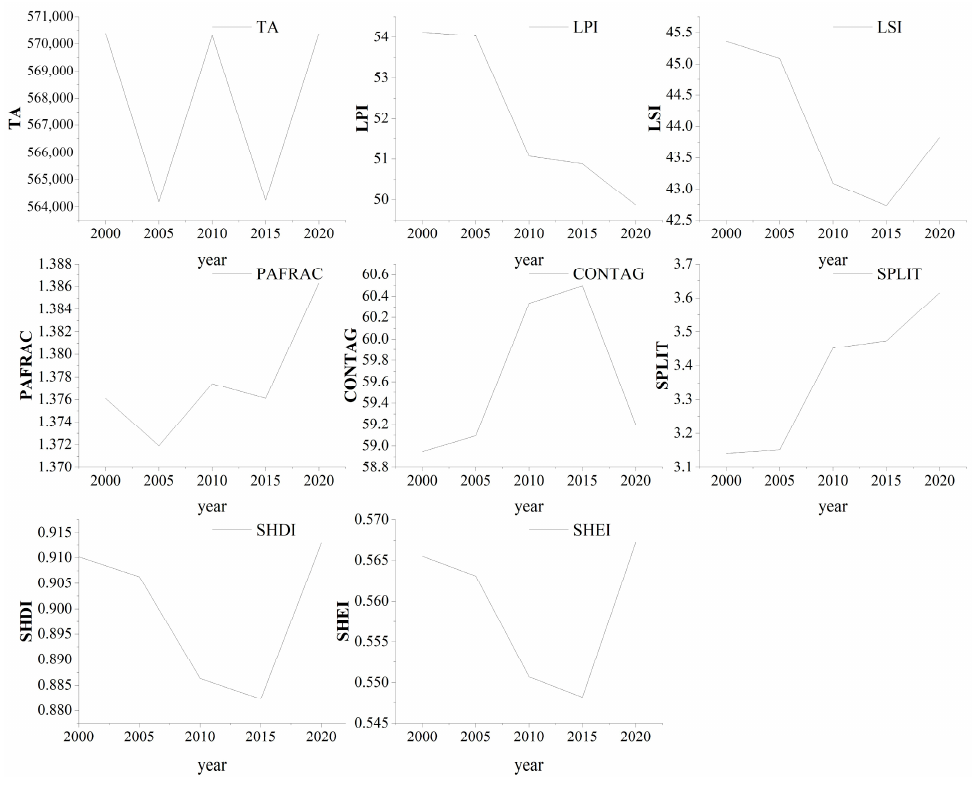
Figure 14. Landscape pattern index 2000–2020.